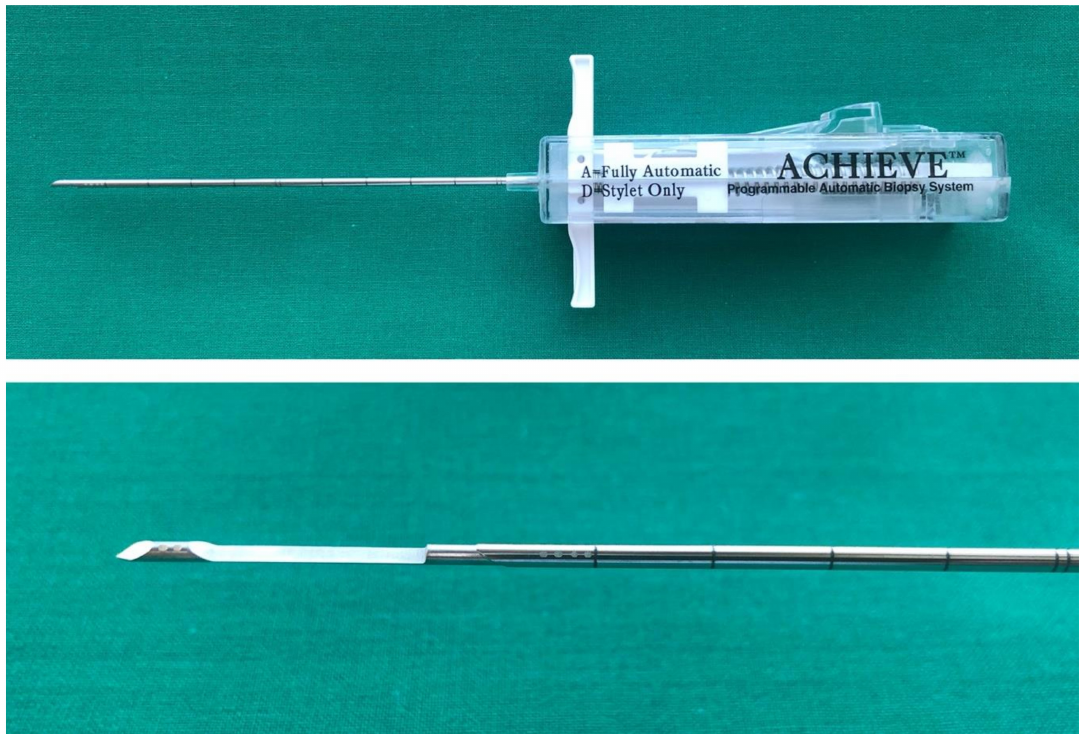
Figure 2. Programmable Automatic Biopsy System (Coaxial Achieve ® , CareFusion Corporation, San Diego, CA,